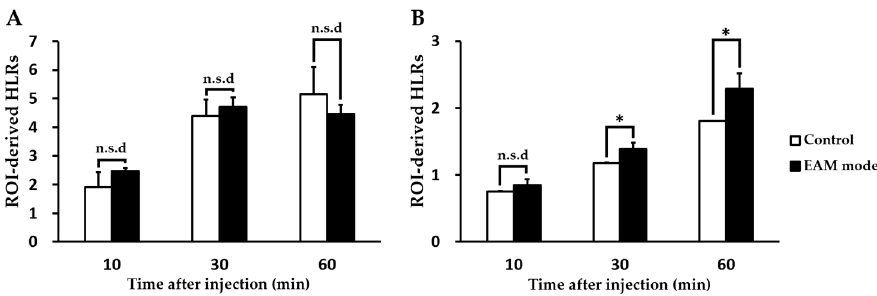
Figure 2. Comparison of incubation time-dependent region of interest (ROI)-derived heart-to-lung ratios of the radiotracers [( A ) for [ 18 F] 1 ; ( B ) for [ 18 F] 2 ] between healthy and experimental autoimmune myocarditis (EAM) rats (each n = 5, respectively). (* p < 0.05). n.s.d; no significant difference. To confirm the TSPO-binding specificity of [ 18 F] 2 , a blocking experiment was performed. In